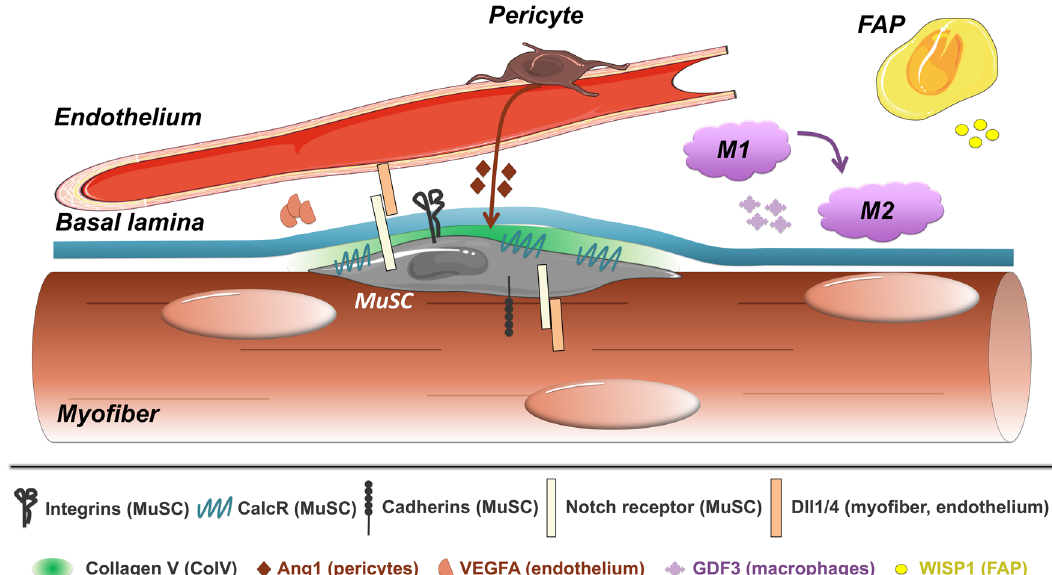
Fig. 4 Interaction between the MuSC and its microenvironment. The MuSC attaches to the basal lamina through integrins, which preserve quiescence, though speci fi c integrins can also promote differentiation. Cadherin proteins attach the MuSC to the fi ber, which expresses Delta ligands required to maintain a Notch-ON state in the MuSC, necessary for quiescence. Notch stimulates the production of Collagen V, which binds and activates Calcitonin receptor, providing a third axis of quiescence control. Dll4 from the endothelium also sustains MuSC quiescence through Notch signaling, which in turn leads to the production of VEGFA from MuSCs. Angiopoietin-1, secreted by pericytes, further contributes to MuSC quiescence. Upon injury, GDF3 from macrophages and WISP1 from FAPs stimulate differentiation and fusion to ensure ef fi cient